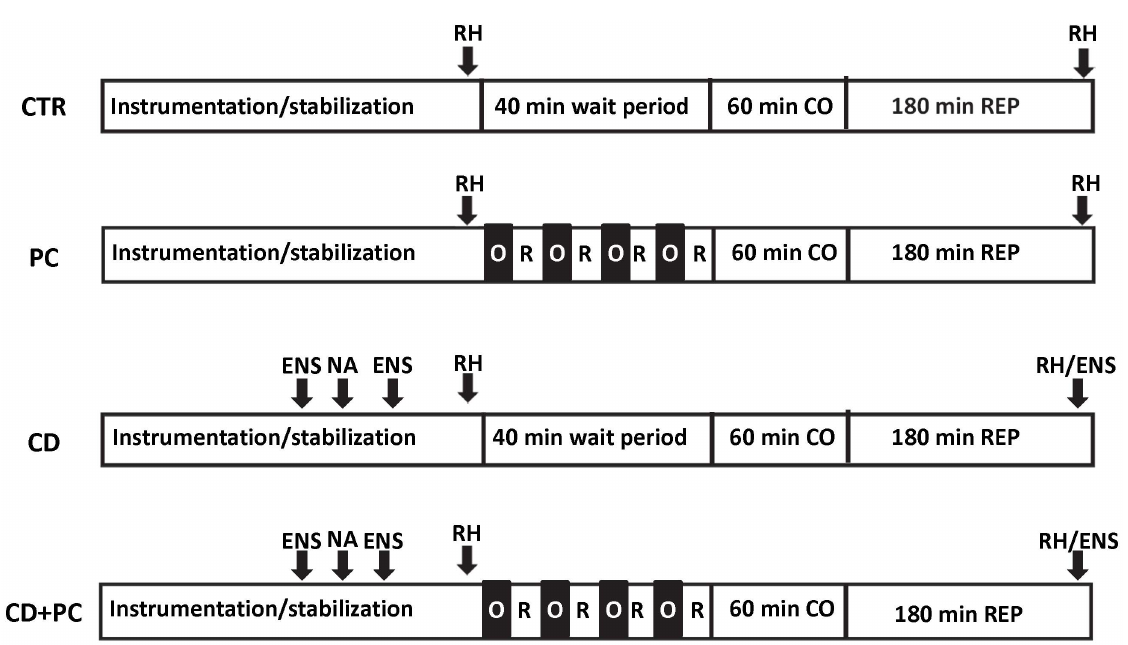
Figure 1. Schematic illustration of the experimental protocols. All dogs underwent 60-min acute CO and REP180. In CTR and CD dogs a 40- min wait period was allowed to compensate for time required for PC (4 cycles of 5-min CO/5-min reperfusion). The time at which reactive hyperemia (RH), nerve ablation (NA) and electrical nerve stimulation (ENS; outlined in Methods) was done is shown.